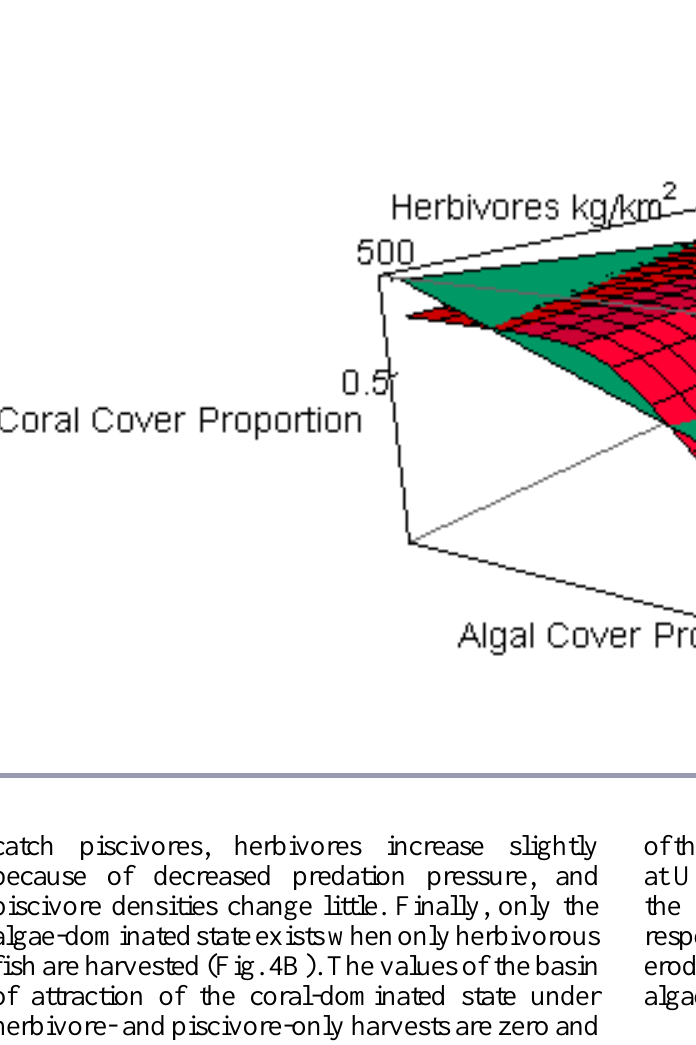
Fig. 2 . Algal and coral nullplanes and the role of